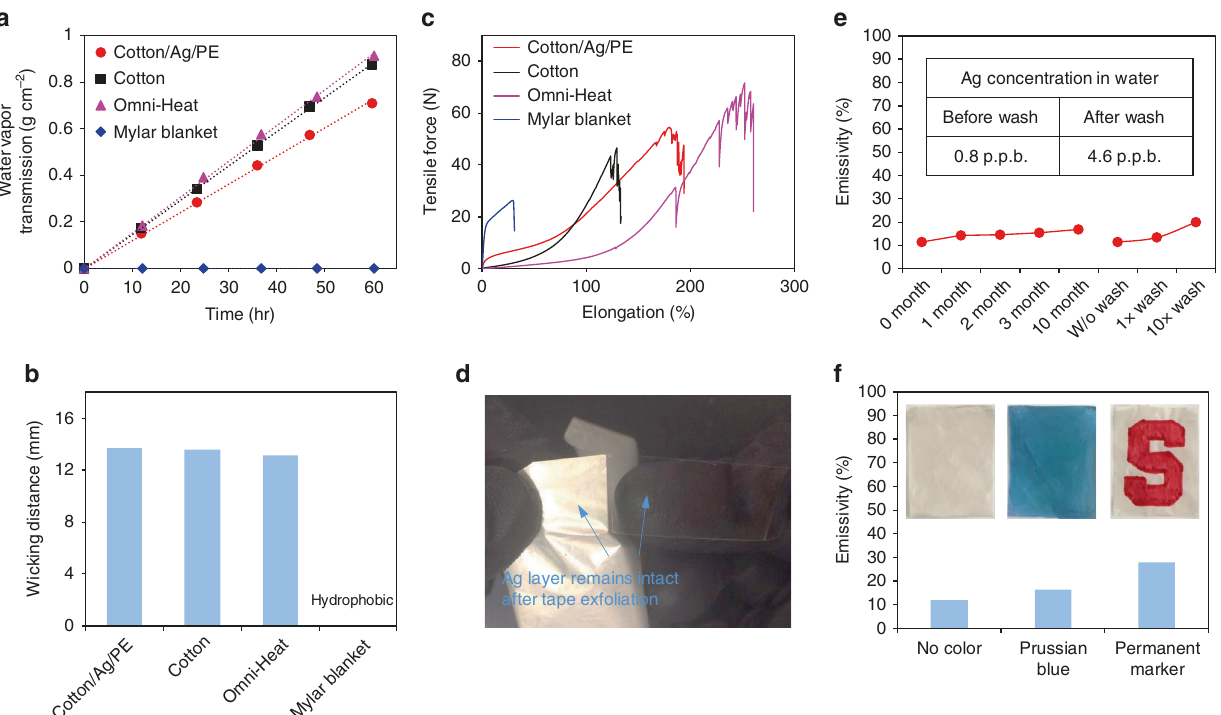
Fig. 4 Wearability tests. Comparison of a water vapor transmission rate, b wicking distance and c tensile strength for cotton/Ag/PE, cotton, Omni-Heat and Mylar blanket. d Adhesion test shows that the coated Ag fi lm is strongly bonded with PE and cannot be removed by an adhesive tape. e Durability test of the cotton/Ag/PE textile sample against washing and handling over time, showing little degradation of the IR emissivity. Inset table lists the Ag concentration in water before and after washing, con fi rming that negligible amount of Ag is released from the textile sample during washing. f IR emissivity comparison of the textile samples with and without coloration. Inset shows photos of the uncolored and colored